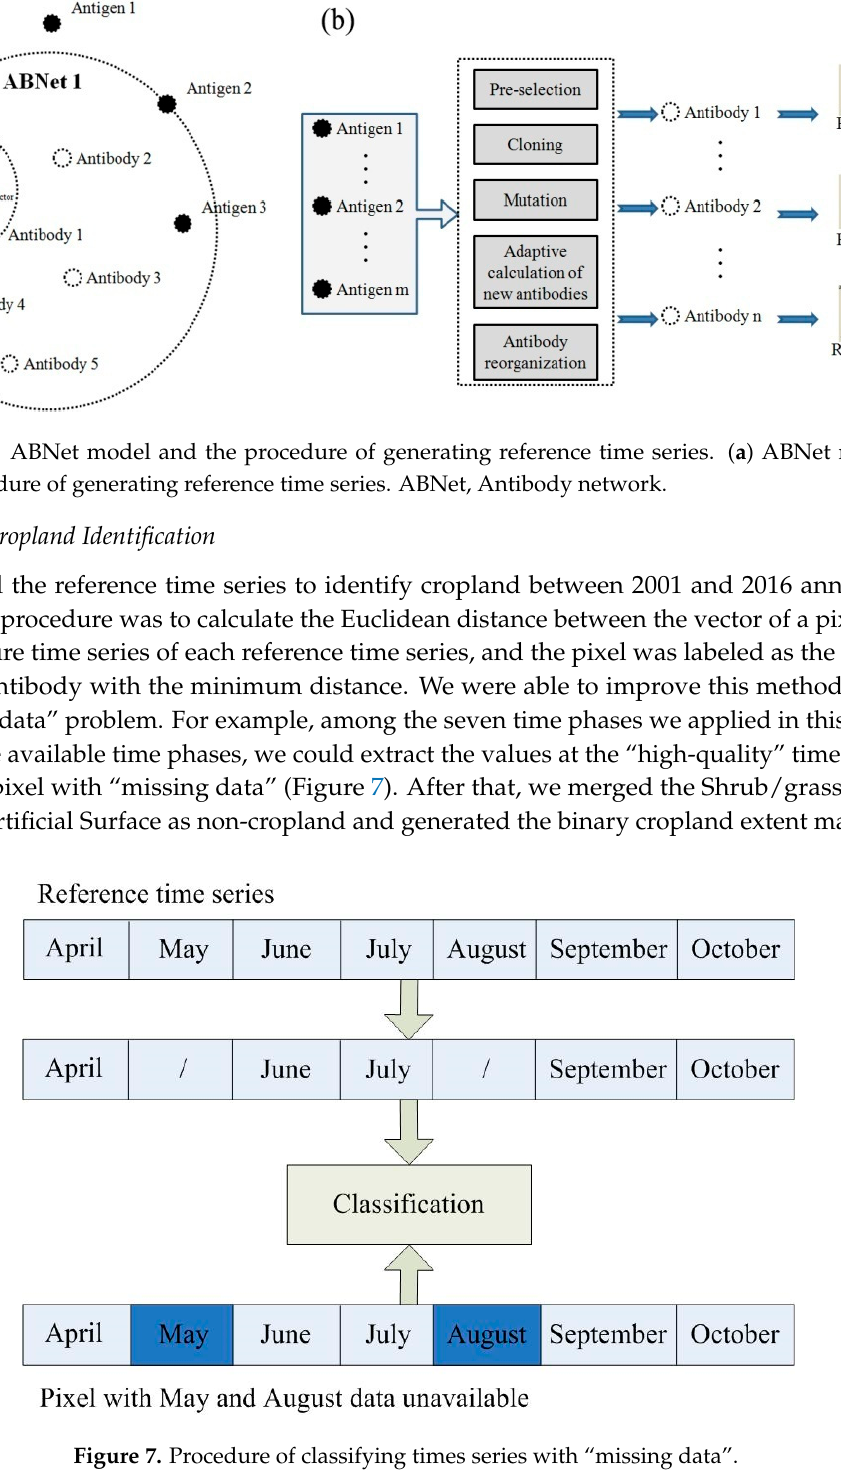
Figure 7. Procedure of classifying times series with “missing data”.